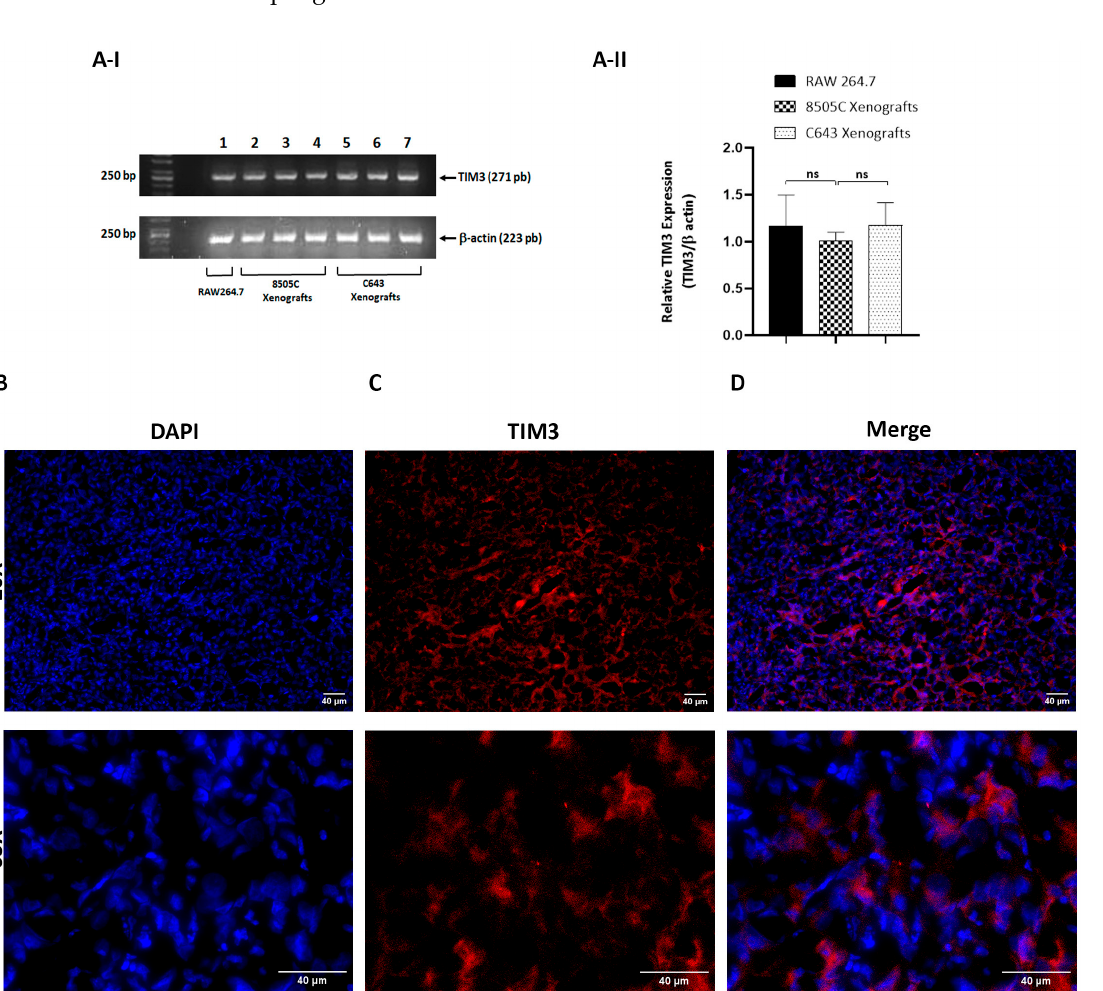
Figure 4. TIM3-positive macrophages were recruited to ATC xenograft tumors. ( A ) I. Upper panel: TIM3 mRNA expression in RAW264.7 cells and in ATC xenografts. Total RNA was isolated, and the mRNA expression of TIM3 was examined by RT-PCR analysis. Lane 1, RAW264.7 cells; lanes 2–4, 8505C xenograft tumors ( n = 3); lanes 5-7, C643 xenograft tumors ( n = 3). The lower panel represents the expression of actin. II. TIM3 mRNA expression was normalized by β -actin. Densitometry anal- ysis of TIM3 is shown. Representative results of 3 independent experiments. ( B – D ) 20X and 63X images of 5 μ m thick 8505C xenograft tumor sections immunostained with TIM3-PE antibody (red). Nuclei were counterstained with DAPI. Representative immunofluorescence images of 3 independ-